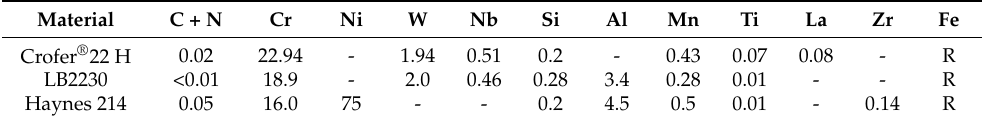
Table 1. Chemical compositions of the investigated materials (wt.%).